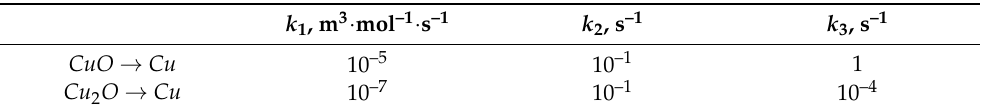
Table 1. Values of k 1 , k 2 and k 3 for processes involving CuO or Cu 2 O at room temperature according to